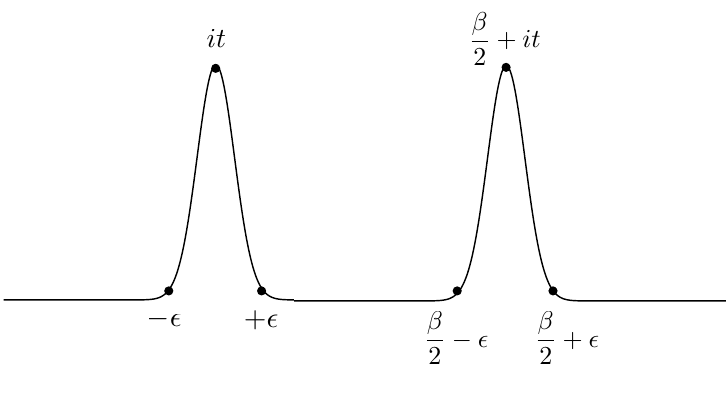
Figure 10 . A complex time contour appropriate for computing the expectation value of the double commutator (8.11). Two operators are inserted at the points it and (cid:12)= 2 + it , and the other two at " and (cid:12)= 2 " (with some choices of the signs. (To make a thermal trace, the left and right ends (cid:6) (cid:6) of the contour should be glued